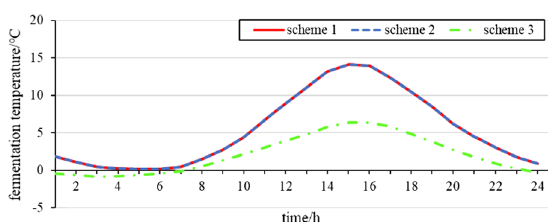
Fig. 18 Biogas fermentation temperature in winter